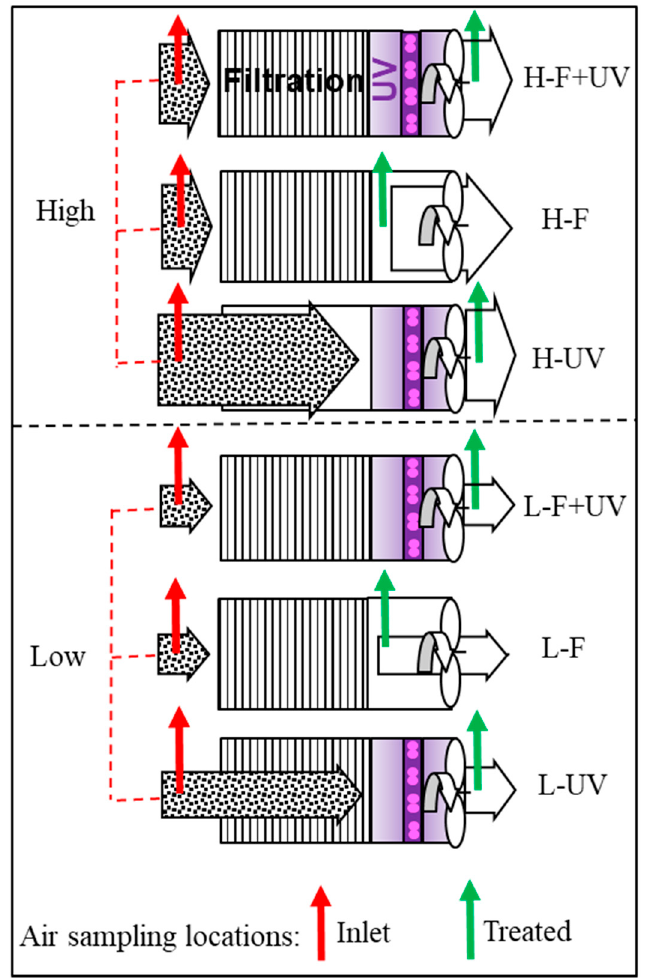
Figure 5. Six air cleaning configuration options were used for testing of FastAir prototype in high (top three panels) and low (bottom three panels) air flow rate modes, with both modes having filtration + UV, filtration only, and UV only options. Red and green arrows signify the sampling locations of the inlet and exhaust (treated) air, respectively, for PM and viable airborne bacteria. Each of the six configuration options was tested three ( n = 3) times in experimental trials.